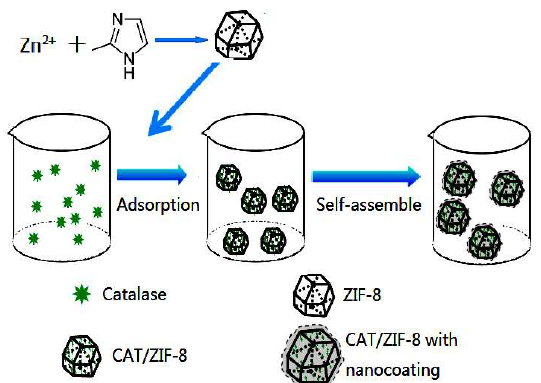
Figure 1 Schematic illustration of the synthesis of catalase (CAT)/ Zeolitic imidazole framework (ZIF)-8, Fe 3+ -TA@CAT/ZIF-8, and SiO 2 @CAT@ZIF-8.